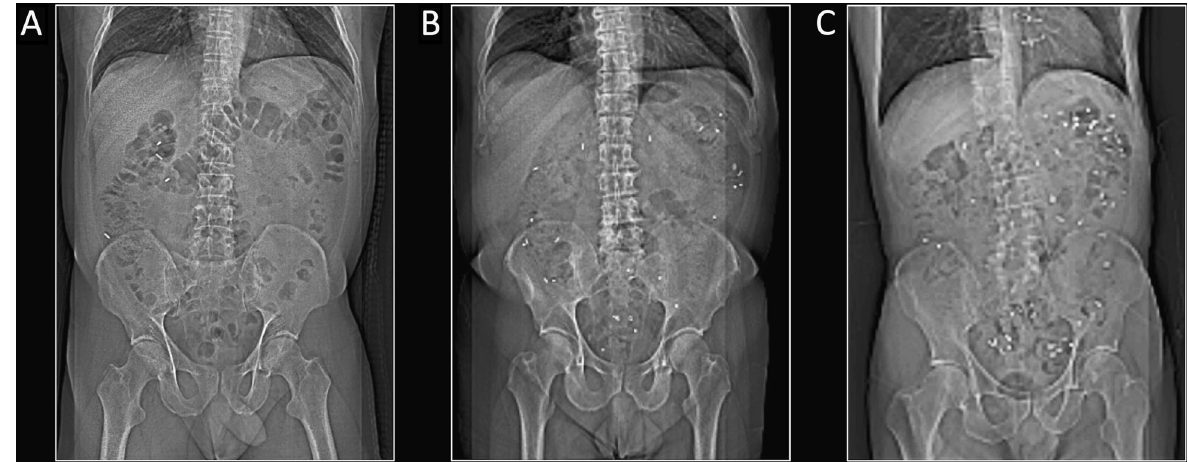
Fig. 4 Radio-opaque marker studies of colonic transit time ( CTT ) using the 7-day (60 marker) protocol. a Healthy control with rapid CTT (4 markers). b PD patient with increased CTT (28 markers). c PD patient with severely increased CTT (57 markers). Note that the markers are situated mostly in the descending and recto-sigmoid colon suggestive of “ outlet obstruction ”